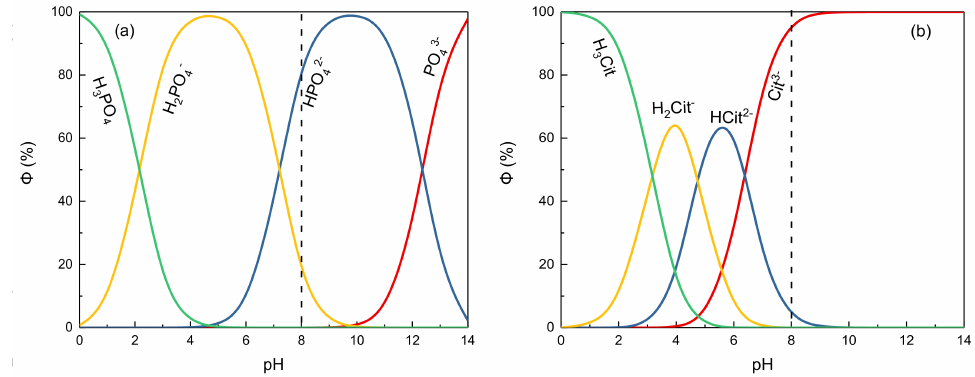
Figure 9. Distribution coe ffi cients of components in SHMP ( a ) and H 3 Cit ( b )